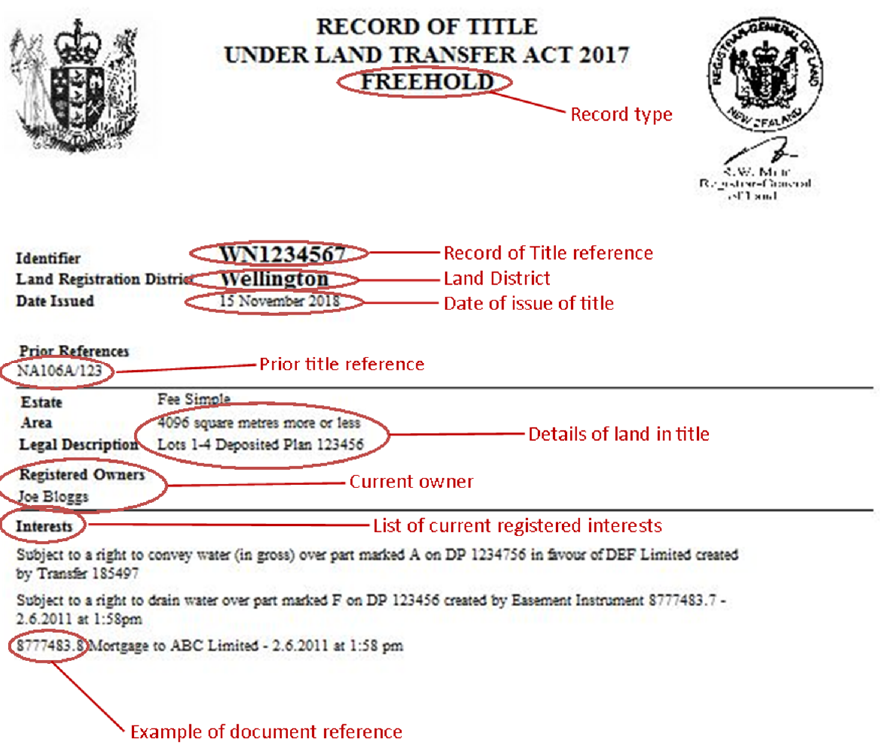
Figure 9. Record of Title. Source: [34].